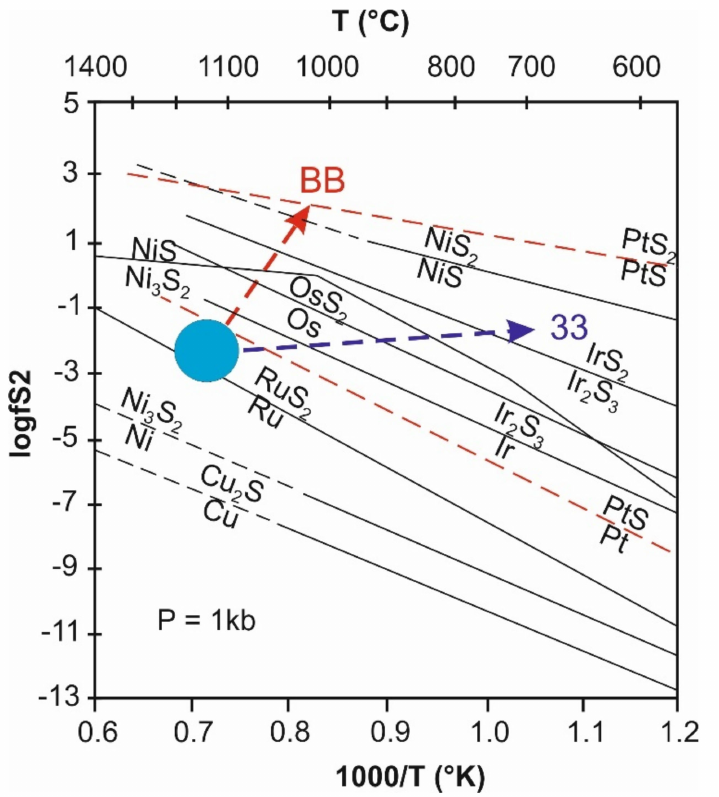
Figure 13. Metal–sulfide reaction lines for PGE (Ru, Os, Ir, Pt) and base metals (Cu, Ni) as functions of temperature and sulfur fugacity. The arrows show the different variation paths of T ◦ C–logf(S 2 ) determined by the different cooling rate, resulting in the stabilization of Laurite (RuS 2 ) in deposit BB, and laurite + erlichmanite (OsS 2 ) + (IrS 2 ) in deposit 33 (modified after